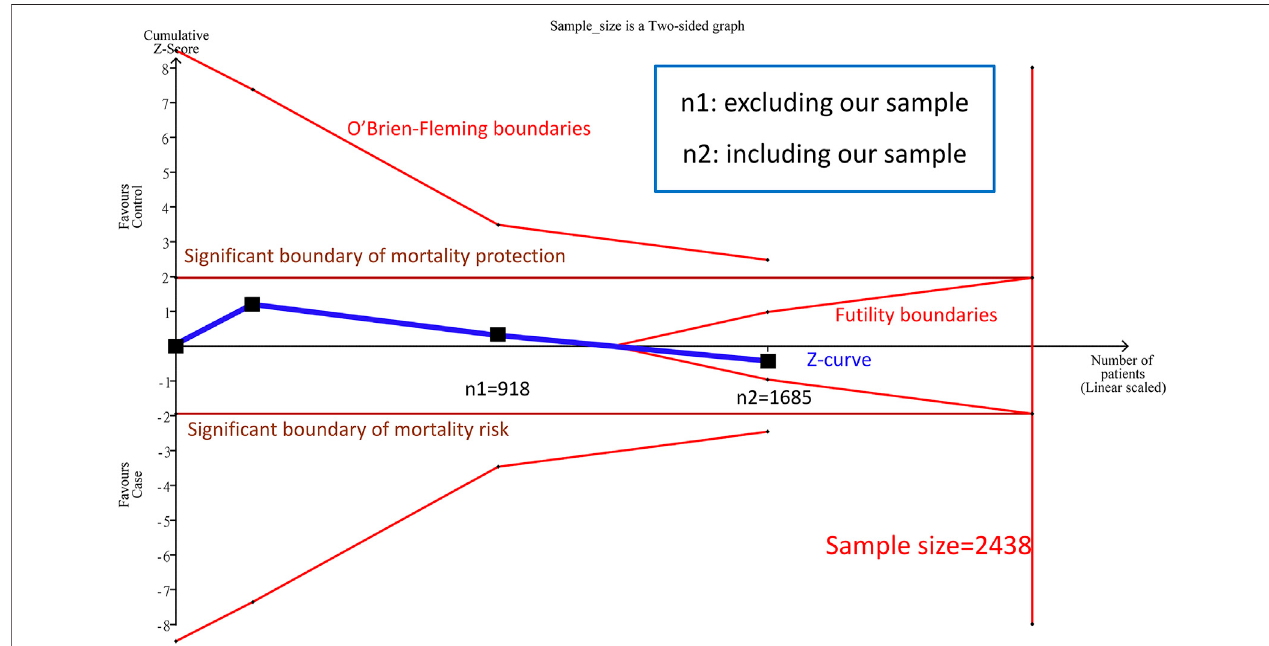
FIGURE2| TrialSequentialAnalysis(TSA)inthismeta-analysisamongAsiansTSAisamethodologythatincludesasamplesizecalculationforameta-analysiswith the threshold of statistical signi fi cance. We performed a TSA using an allele model assumption but replaced the allele count with the sample size (divided by 2). Detailed settings:Signi fi cancelevel=0.05;power=0.95;ratioofminortomajor=1;hypotheticaloutcomeincidenceofDalleleincontrol=0.03;leastextremeRRtobedetected = 0.67; I 2 (heterogeneity) =